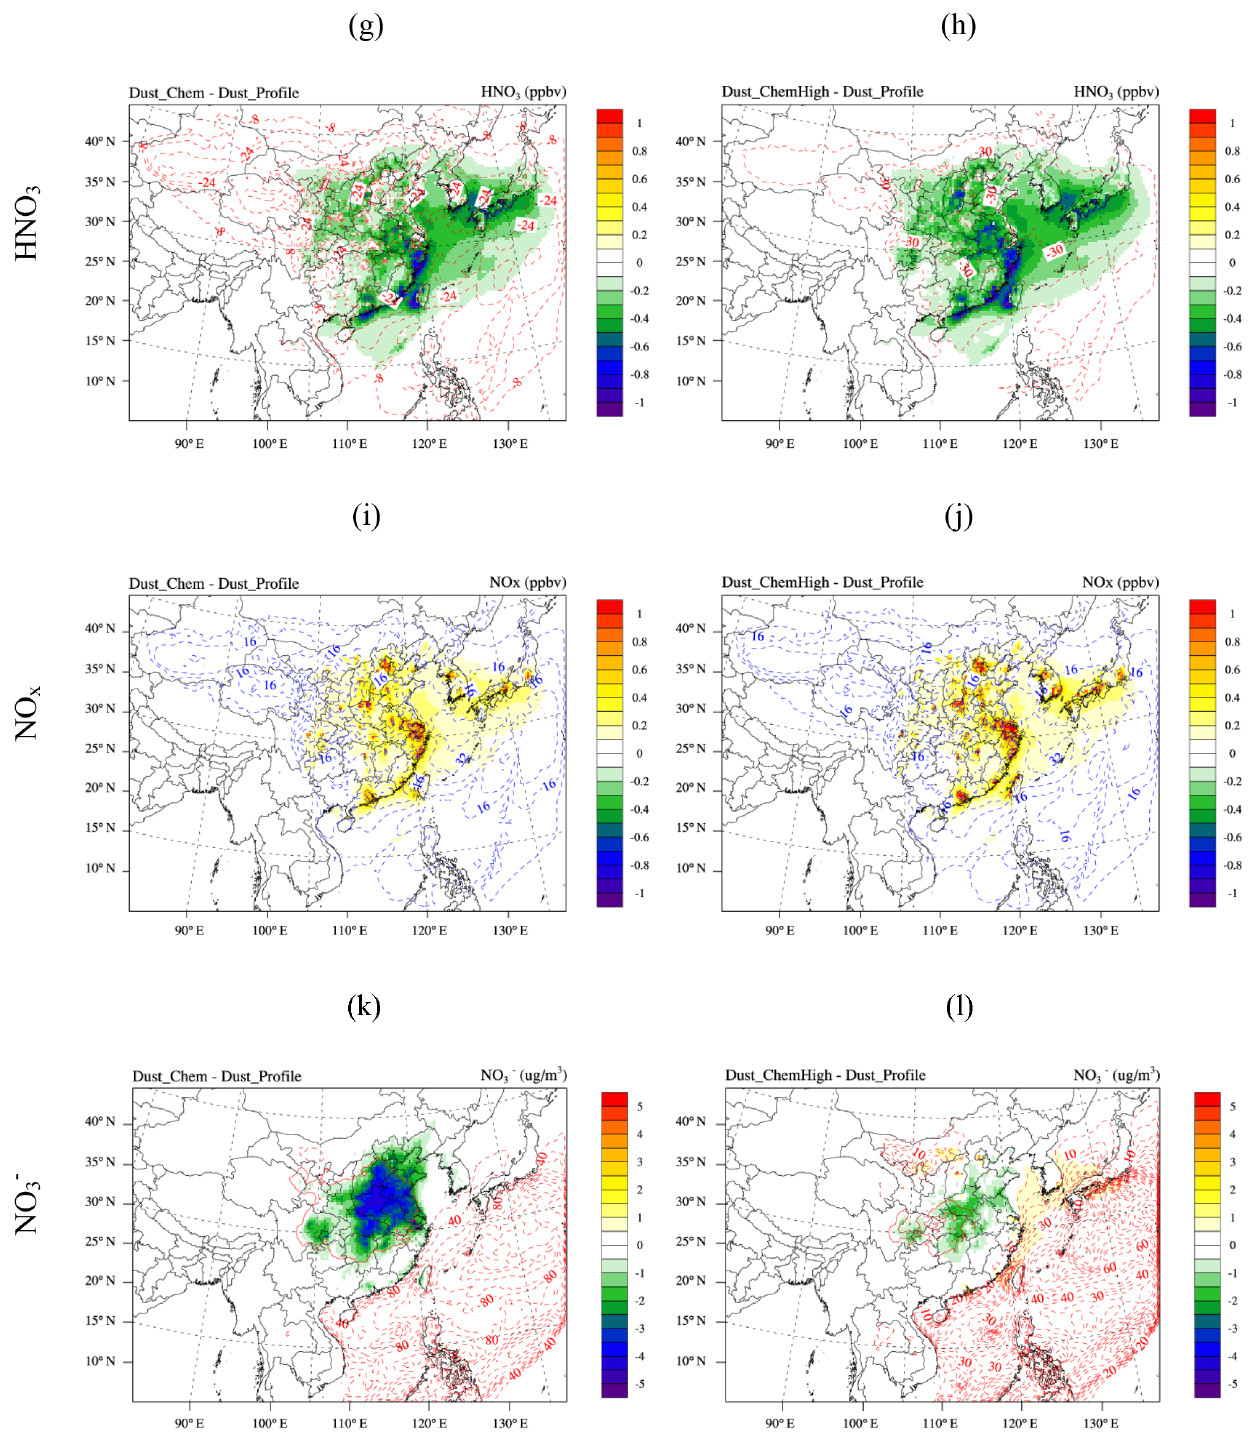
Figure 6. Five-year averages for March and April from 2006 to 2010 of dust heterogeneous chemistry impacts with lower (left column) and upper (right column) uptake coefficients for species O 3 , SO 2 , SO 2 − concentration changes and dashed contour lines with numbers indicate the percentage